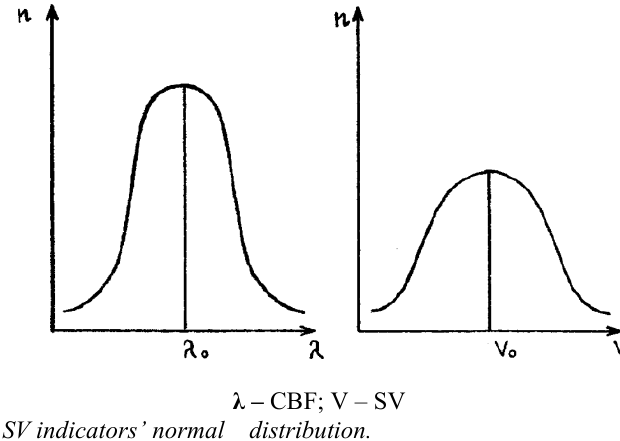
Fig.1. Diagram of CBF and SV indicators’ normal distribution.